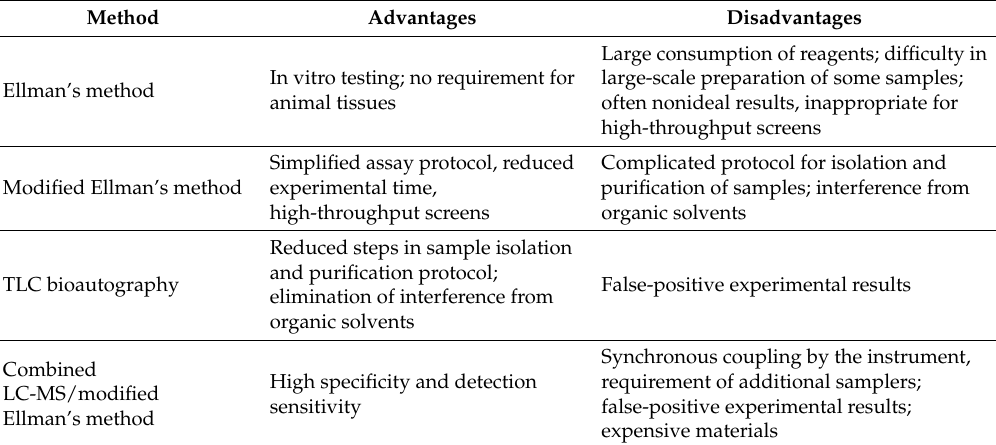
Table 1. Comparison of methods used for in vitro AChEI